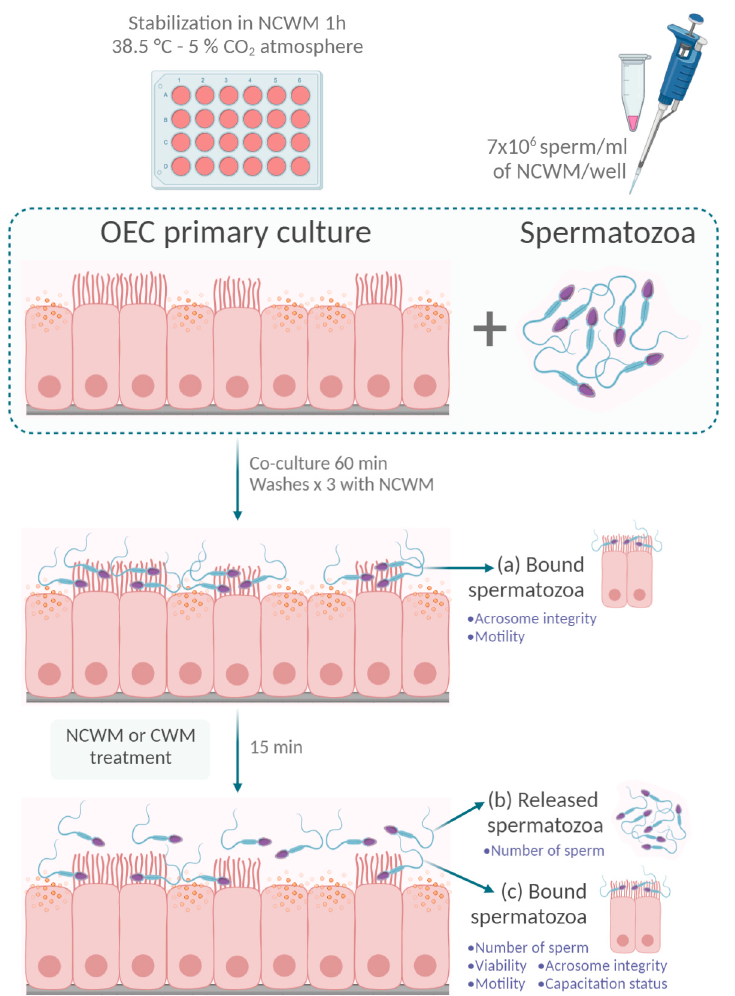
Figure 1. Oviductal epithelial cells and sperm co-culture experimental design. Confluent oviductal epithelial cell (OEC) monolayers were stabilized with non-capacitating modified Whitten’s base medium (NCWM) 1 h before sperm addition. Scheme 7 × 10 6 sperm/mL of NCWM) were added to each well and were co-cultured with OECs for 60 min at 38.5 ◦ C in a 5% CO 2 atmosphere. Unbound spermatozoa were removed by washing the monolayers three times with NCWM. Acrosome status and motility were evaluated on ( a ) sperm that remained bound to OECs. Next, the sperm–OEC co-cultures were incubated with NCWM or capacitating medium (CWM) for 15 min. After that time, monolayers were washed three times with NCWM to analyze ( b ) the number of released sperm and ( c ) the number, viability, motility, acrosome integrity and capacitation status of the sperm that remained bound to the OECs after treatments. Created with BioRender.com.